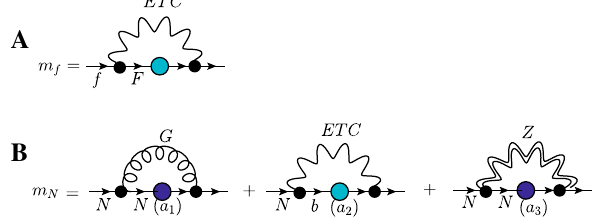
Fig. 2 The standard mass diagram in TC theories is shown in part a of the figure. It connects ordinary fermion to technifermions through ETC interactions. In the coupled TC scheme more diagrams are taken into account, e.g. the techni-neutrino mass has all the contributions shown in part b of the